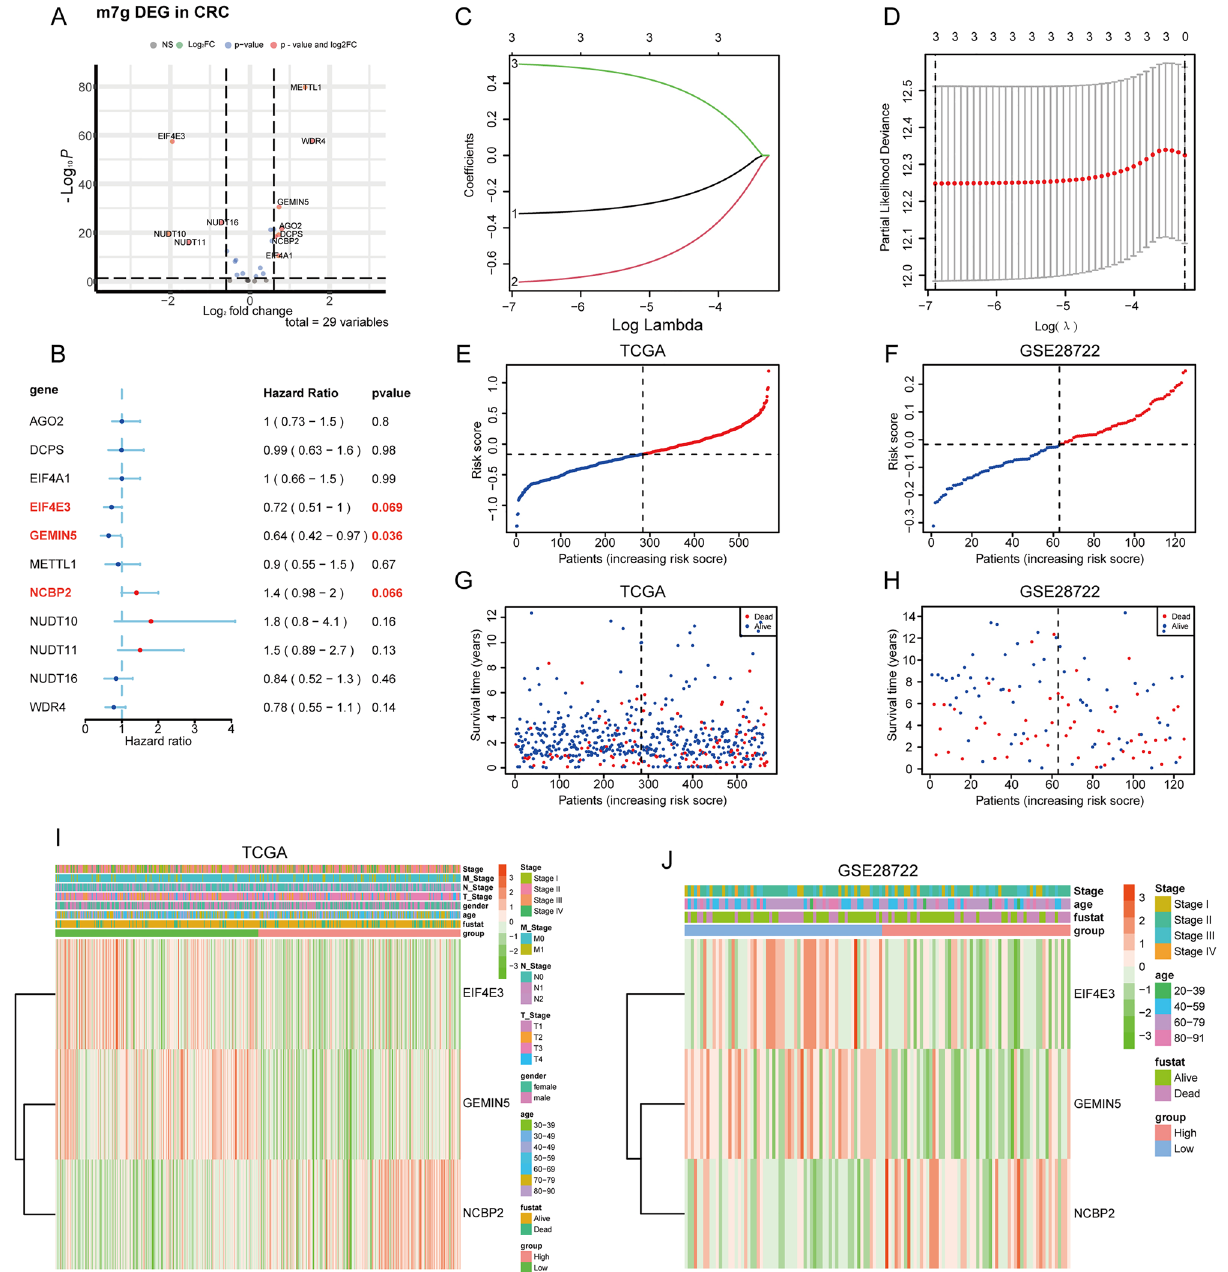
Figure 2. MRS model construction. ( A ) The volcano map depicts 29 identified m 7 g-related genes visualized by EnhancedVolcano package in R language (version 4.1.2). ( B ) Selection of m 7 G-associated genes exhibiting significance in univariate Cox analyses (|logFC|> 0.6, adj.P < 0.1). ( C ) Numbers and coefficient values for different λ values during model construction. ( D ) Continuous adjustment of potential model parameters ultimately yielded the best model (left dashed line) and the simplest model (right dashed line), with the above values corresponding to the number of model features at the indicated λ value. ( E , F ) Risk score distributions based on the m 7 G-associated gene model in the training and validation datasets. ( G , H ) Differences in survival outcomes between patients in the high- and low-MRS subgroups in the training and validation datasets. ( I , J ) Heatmap represents the expression levels of three selected m 7 g-related genes in individual patients, plotted using the pheatmap function in the pheatmap package of the R language (version